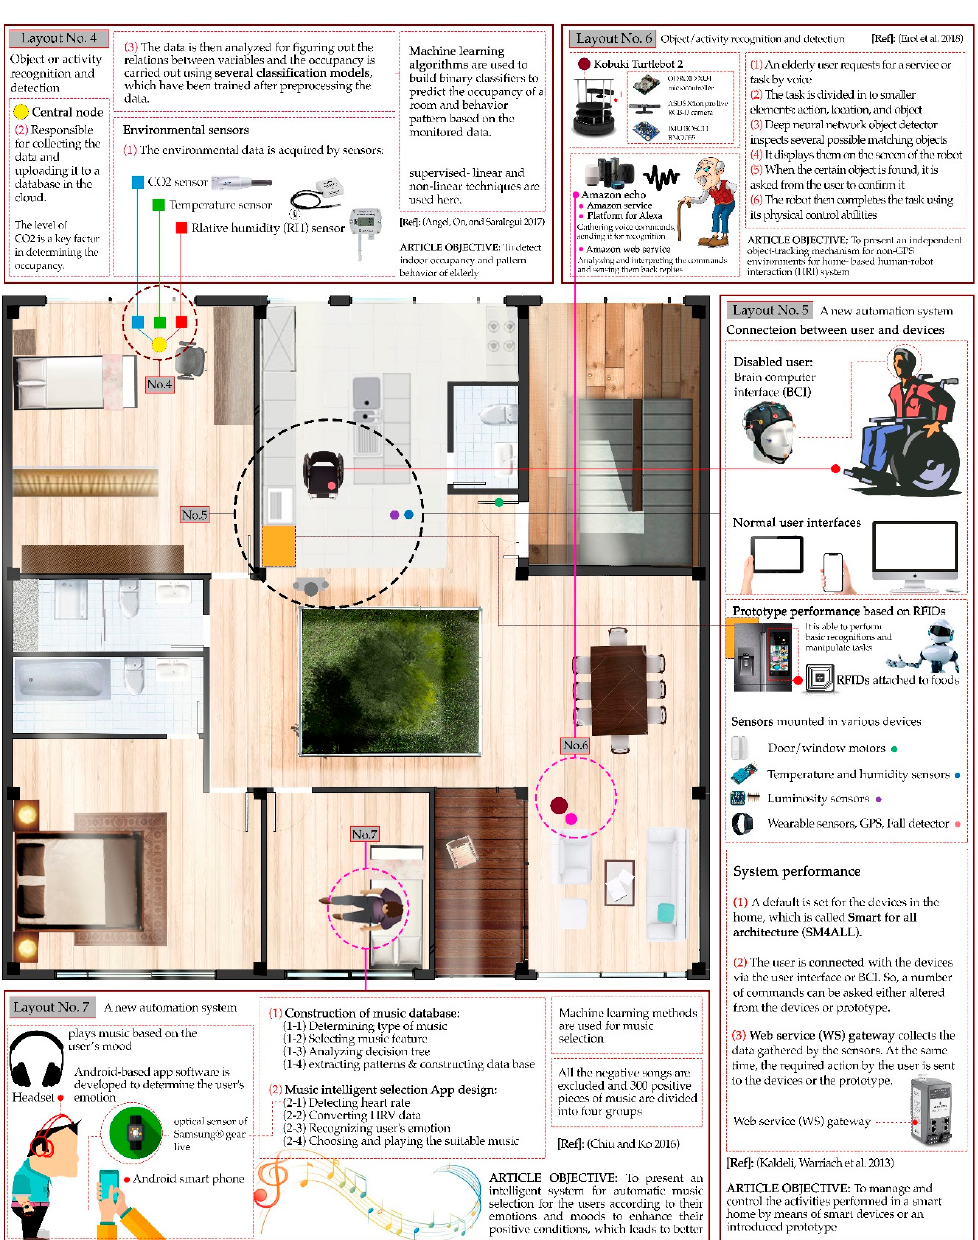
Figure 11. A typical smart home plan, including four layouts, which take advantage of a number of sensors. Note: This smart home integrates 5 smart systems, including: (1) a system able to recognize objects and activities to detect indoor occupancy and pattern behavior of elderly [81] that is visualized in layout number 4 by authors, (2) a system able to manage and control the activities performed in a smart home [82] that is visualized in layout number 5 by authors, (3) a system for independent object-tracking for non-GPS environments in a home-based human-robot interaction system [83] that is visualized in layout number 6 by authors, and (4) a system able to select music automatically according to users’ emotions and moods [ 64 ] that is visualized in layout number 7 by authors. The location of sensors is schematically shown in the figure and can be relocated.